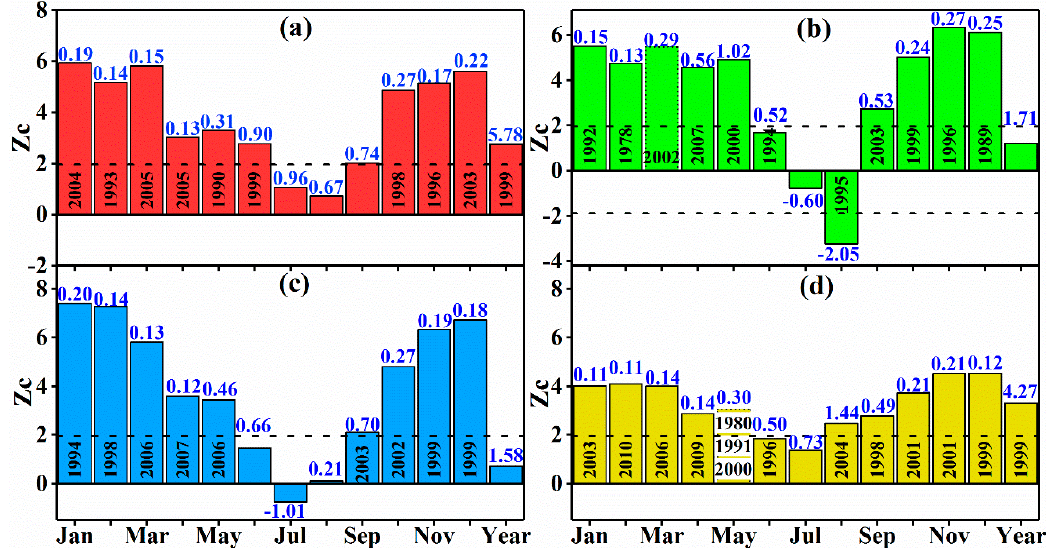
Figure 11. Results of Mann-Kendall (M–K) trend test of monthly and annual runoff depth during 1957–2017 of the ( a ) YRK, ( b ) KRK, ( c ) YUK, and ( d ) KRY. The top of bars represents the runoff depth change rate in mm/decade, the numbers in bars represent the change point year, and the dotted lines represent the critical Zc at a significance level of 0.05.